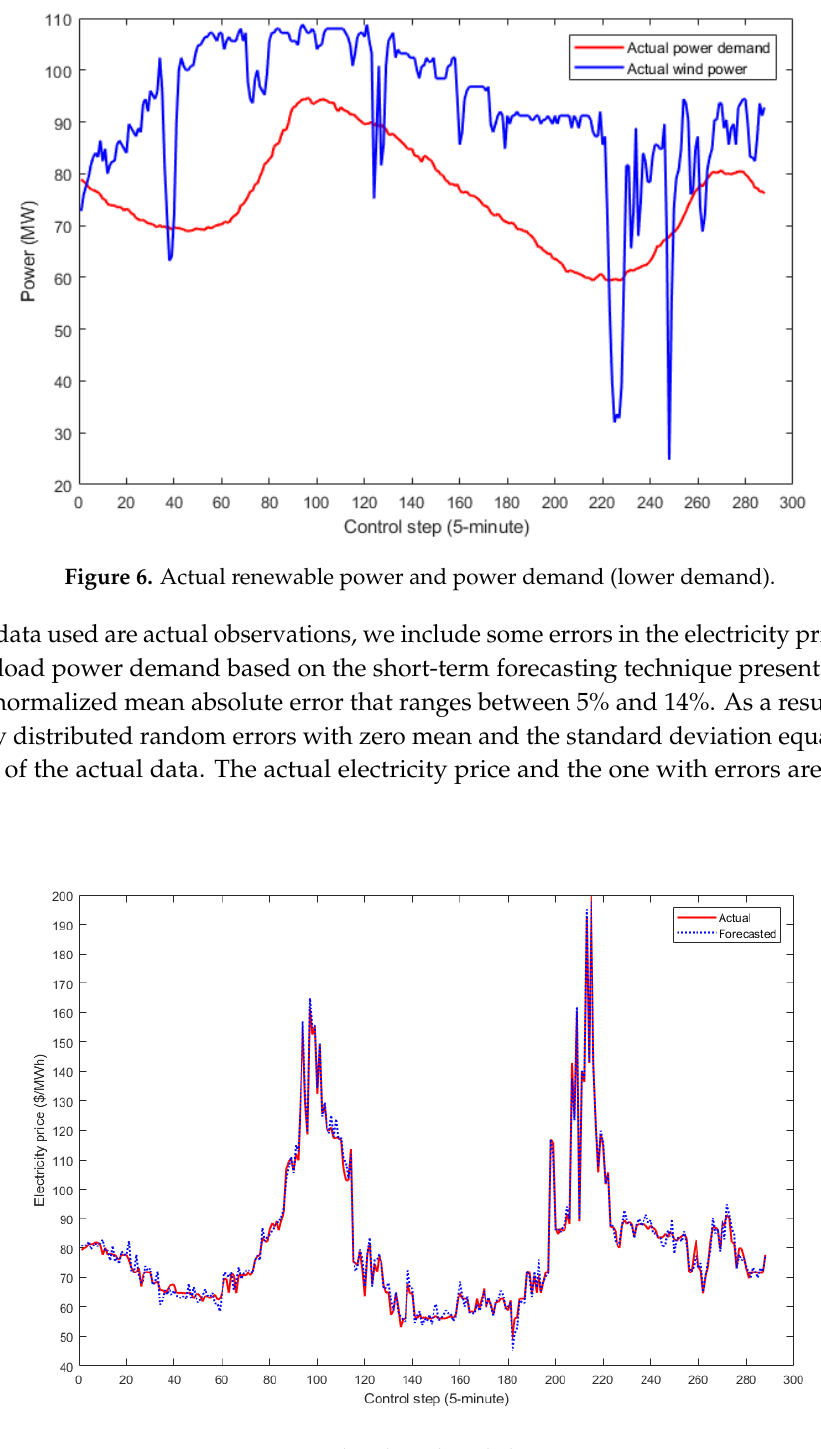
Figure 7. Actual and predicted electricity